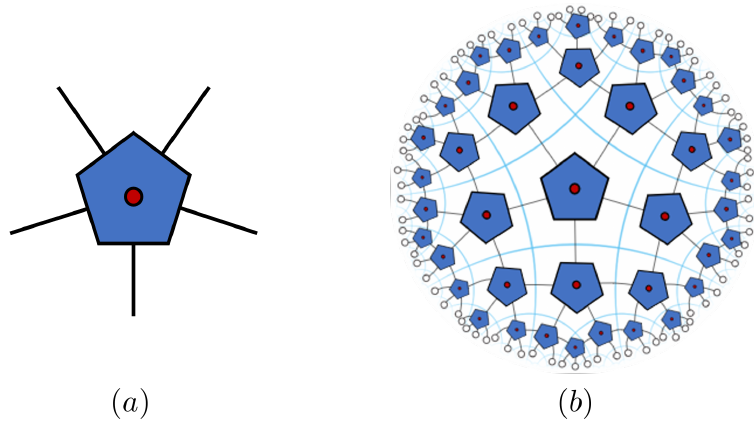
Figure 12 . [[5 , 1 , 3]] encoding tensor and the HaPPY pentagon code. The logical leg of the single qubit input is represented as a red